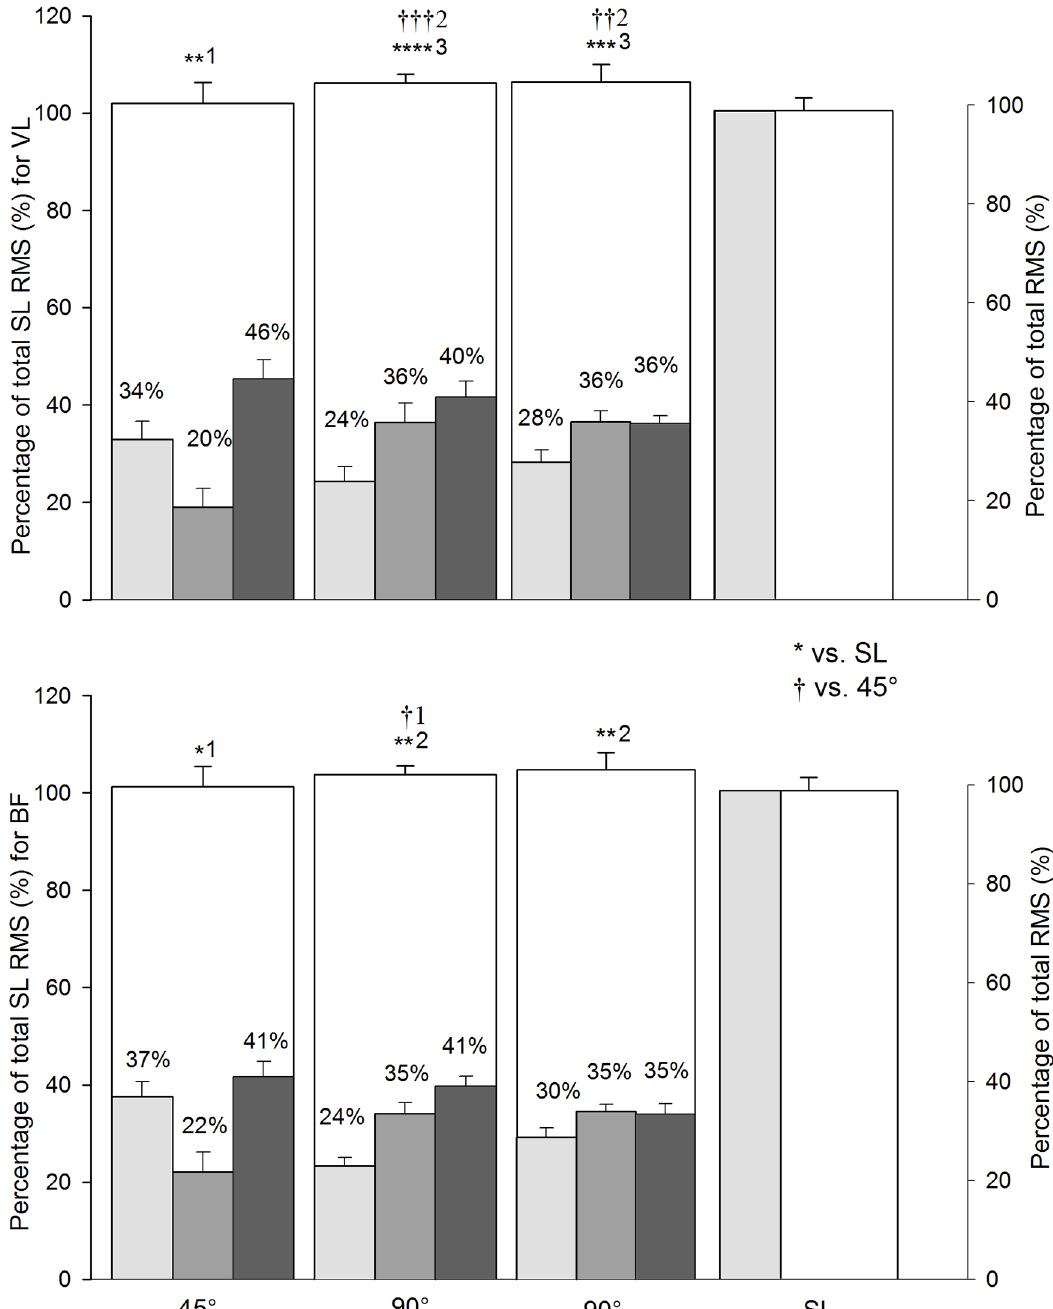
Fig 4. Electromyography amplitude (RMS) of 2 muscles during sprints with (45° or 90°) or without (i.e., straight-line, SL) one change of direction (COD). The upper panel concerns the vastus lateralis muscle and the lower panel, the biceps femoris muscle. 90° 25 : 25-m sprint with one 90°-COD. The number of ‘ * ’ and ‘†’ refers to possible, likely, very likely and almost certain difference versus straight-line and 45°-COD sprints, respectively. The associated number refers to the magnitude of the difference, with 1 standing for small, 2 for moderate, 3 for large and 4 for very large magnitude.